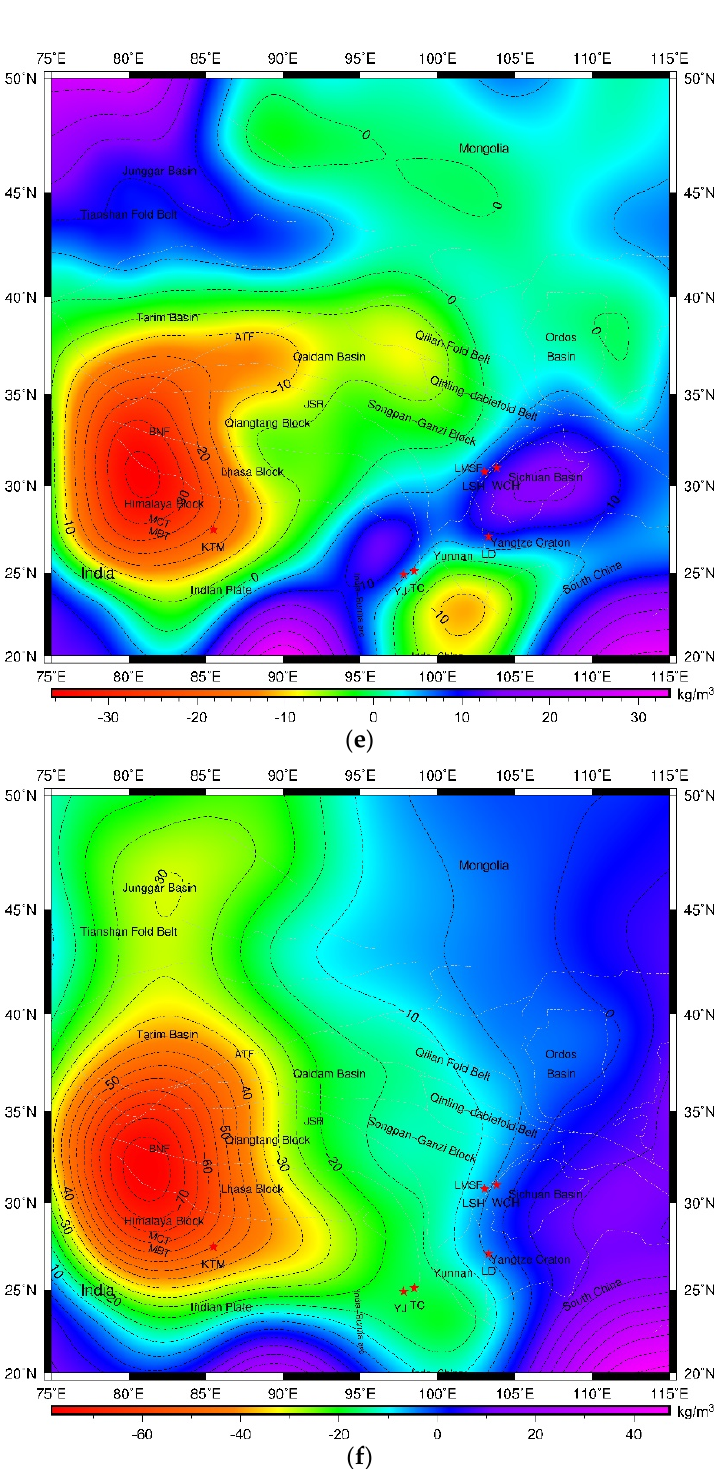
Figure 5. ( a ) Map of the horizontal density distribution at a depth of 50 km; ( b ) map of the horizontal density distribution at a depth of 150 km; ( c ) map of the horizontal density distribution at a depth of 250 km; ( d ) map of the horizontal density distribution at a depth of 350 km; ( e ) map of the horizontal density distribution at a depth of 450 km; and ( f ) map of the horizontal density distribution at a depth of 600 km.